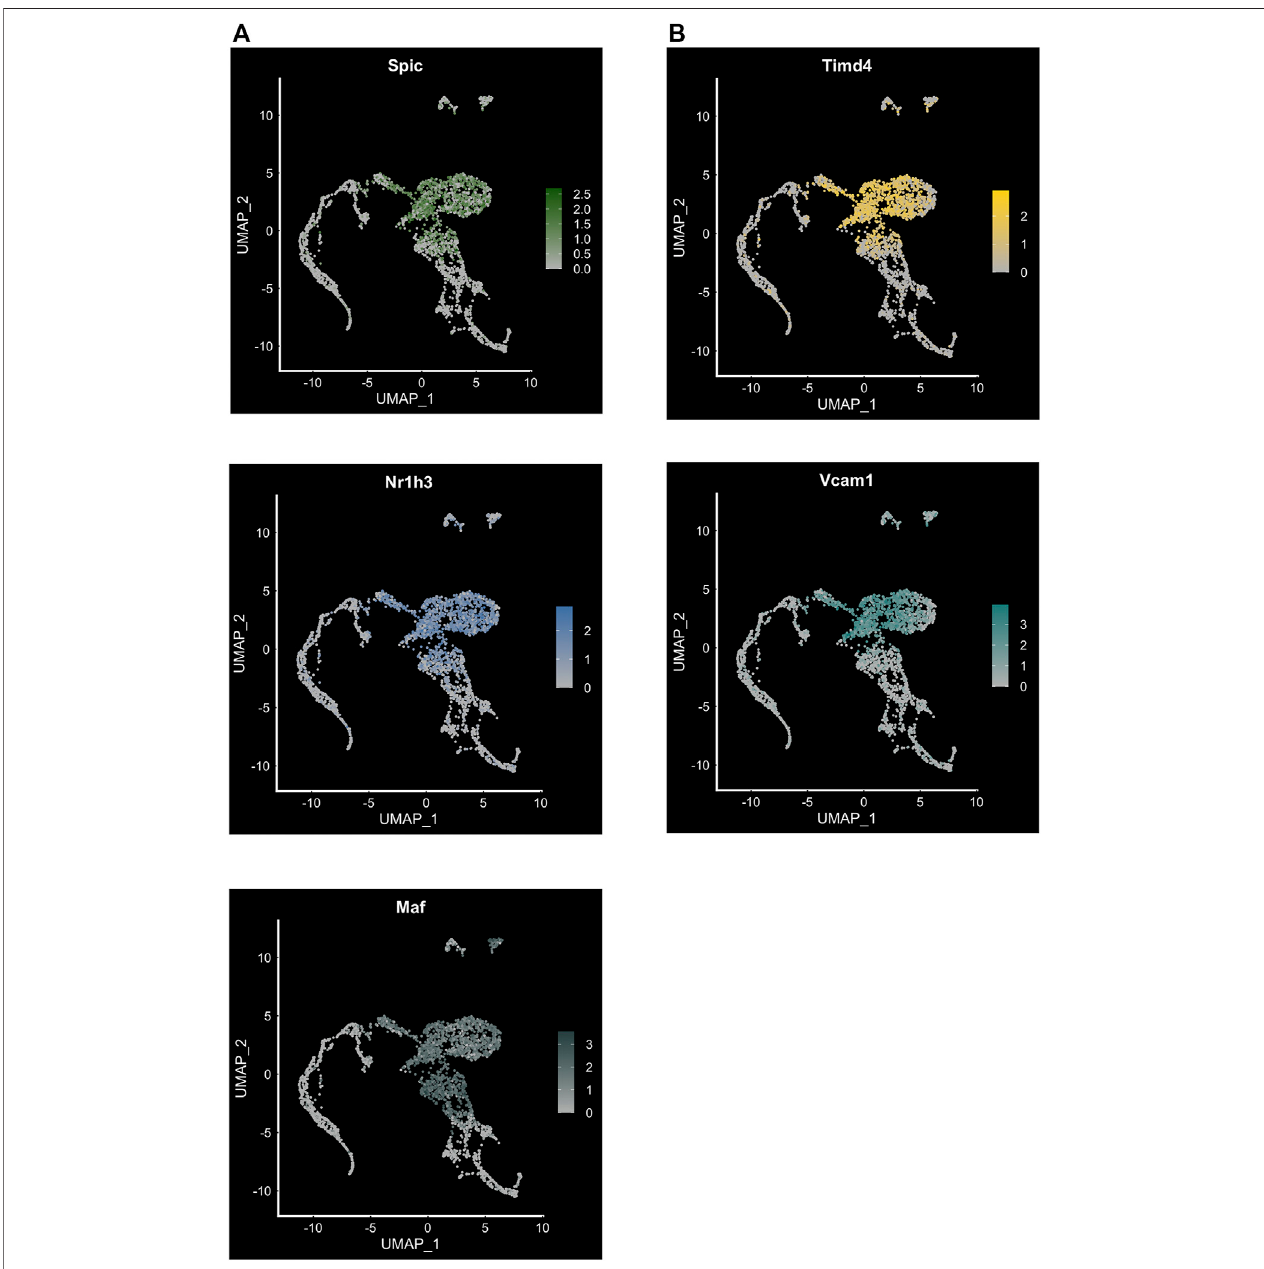
FIGURE 4 | Transcription factor expression and cell surface markers in FL macrophage subpopulations. (A) Feature plot showing expression of transcription factors Spic , Maf and Nr1h3 in the EKLF − / − subpopulation of FL macrophages (compare to Figure 3C ). (B) Feature plot showing expression of cell surface markers Timd4 associated with Spi-C +, and Vcam1 associated with Maf+/Nr1h3 +